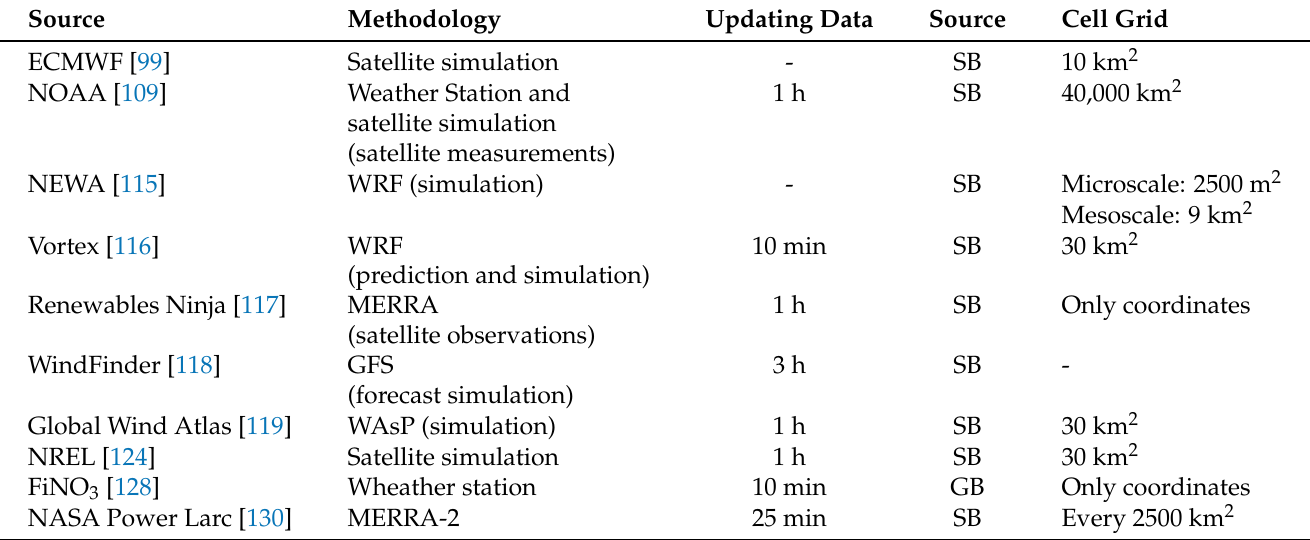
Table 4. Methodology, minimum downloading data frequency, source, and cell grid size. SB, satellite- based; GB,